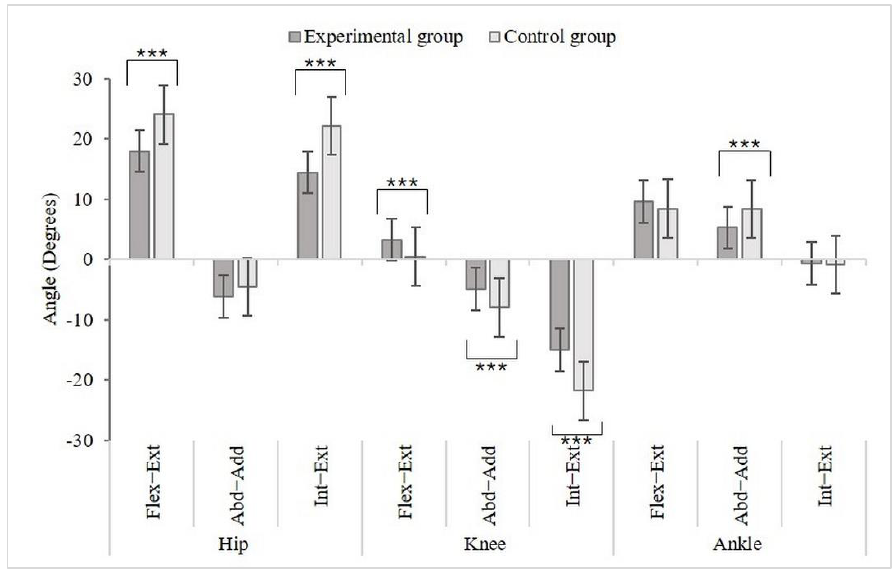
Figure 8. The joint angles for the hip, knee, and ankle during walking. ***, p < 0.001. Table 6. The joint angles for the hip, knee, and ankle during walking (degree).